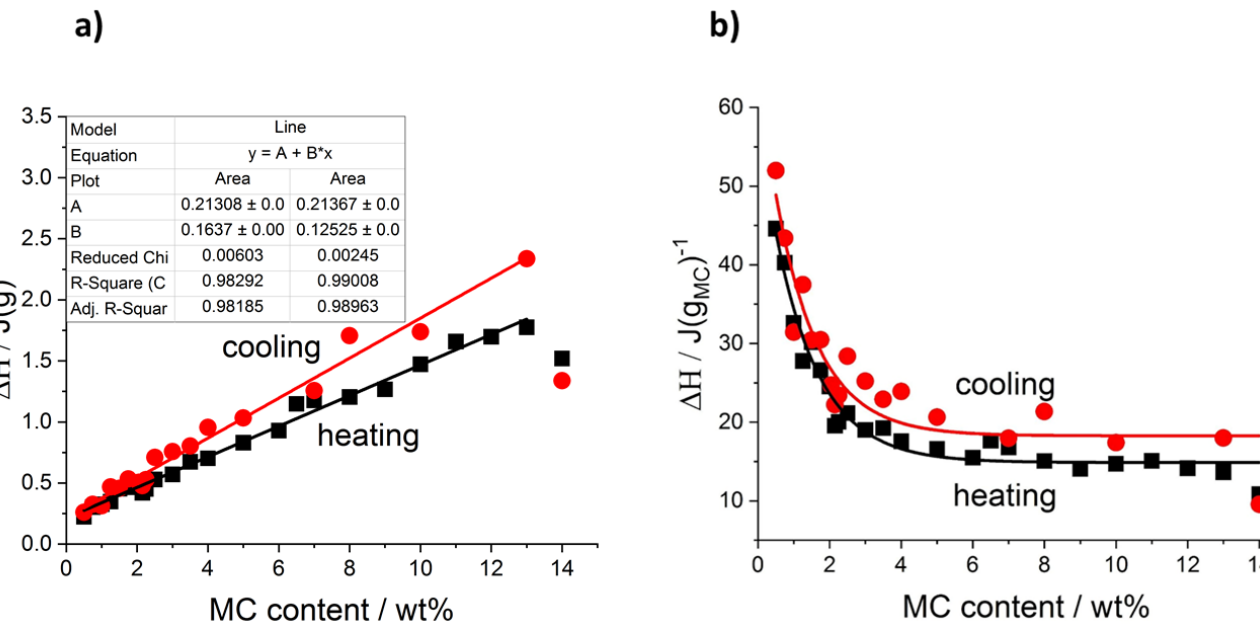
Figure 3. Total transition heat determined during heating and cooling: ( a ) normalized to the sample mass, ( b ) normalized to the MC content mass.